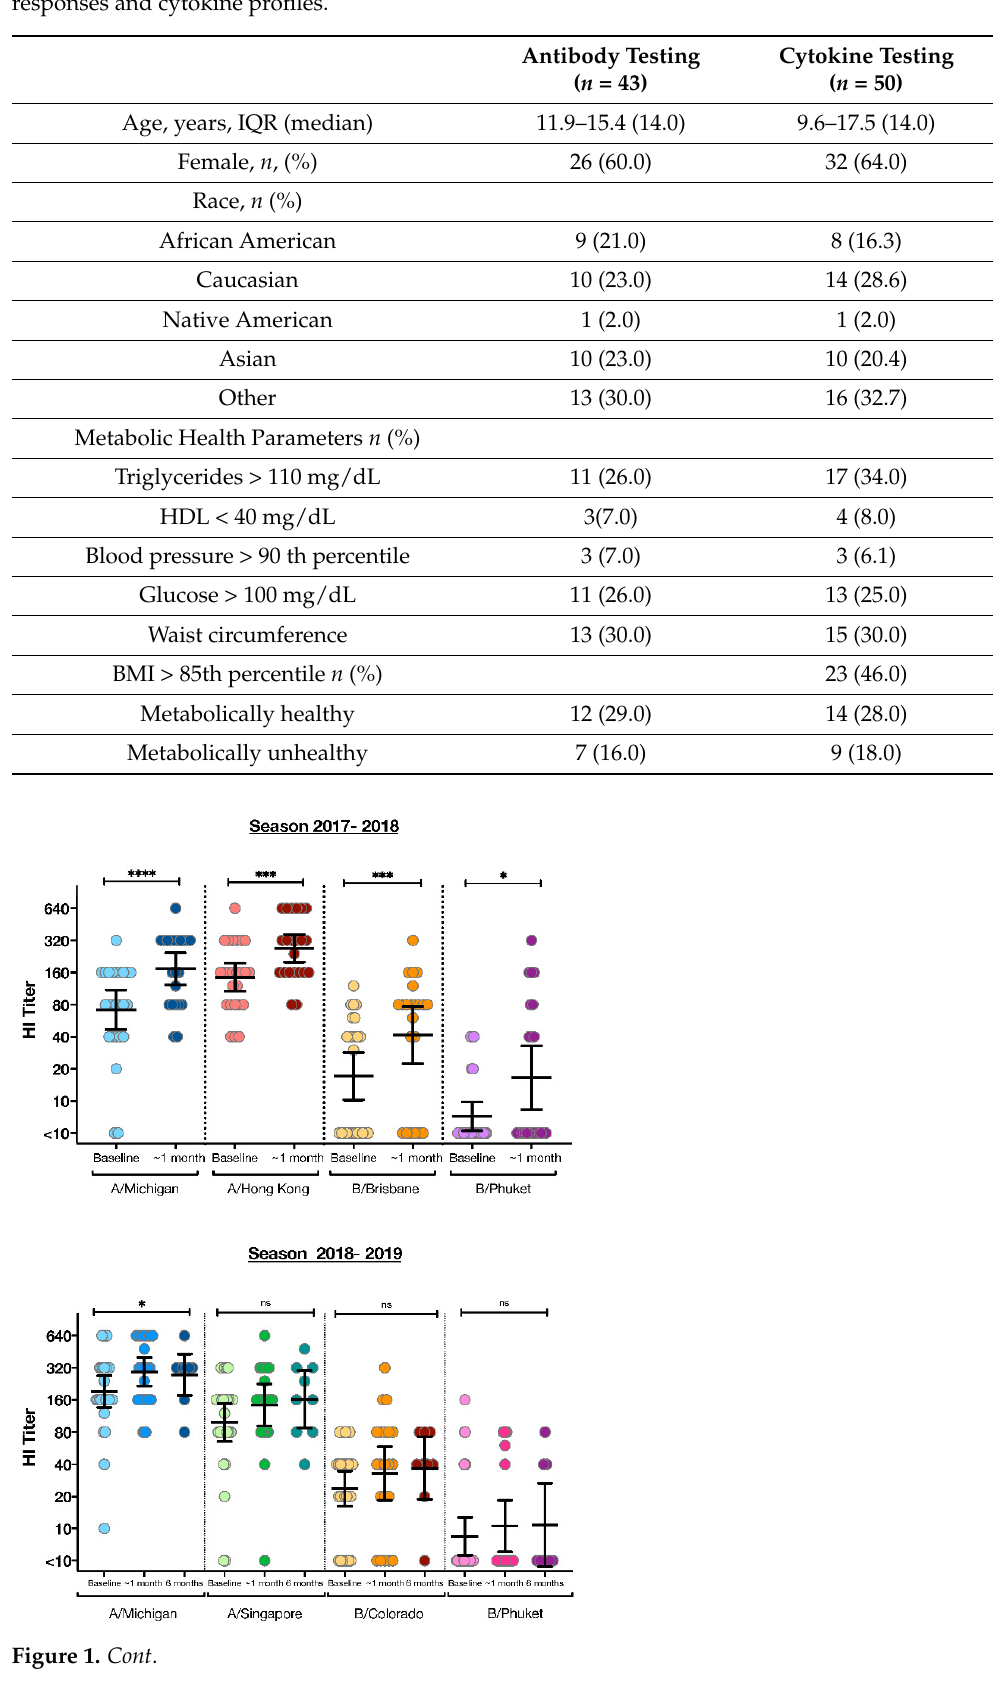
Figure 1. Characterization of influenza responses in the entire cohort of children measured by hemagglutination inhibition (HI) assays. HI titers before vaccination (at baseline), ~1 month, and 6 months after vaccination are shown for each of the vaccine strains contained in the quadrivalent influenza vaccine (Fluzone) for three consecutive seasons (2017–2018, 2018–2019, 2019–2020). **** p < 0.0001; *** p < 0.001, * p < 0.05. ns: indicated Not Significant. Table 2. Pre-existing antibody responses before vaccination against influenza A/H1N1 and H3N2 and influenza B/Victoria and Yamagata lineages according to BMI and metabolic status. A total of 58 subjects had serum sampled before vaccination. From these 58 subjects, 35 were classified as BMI